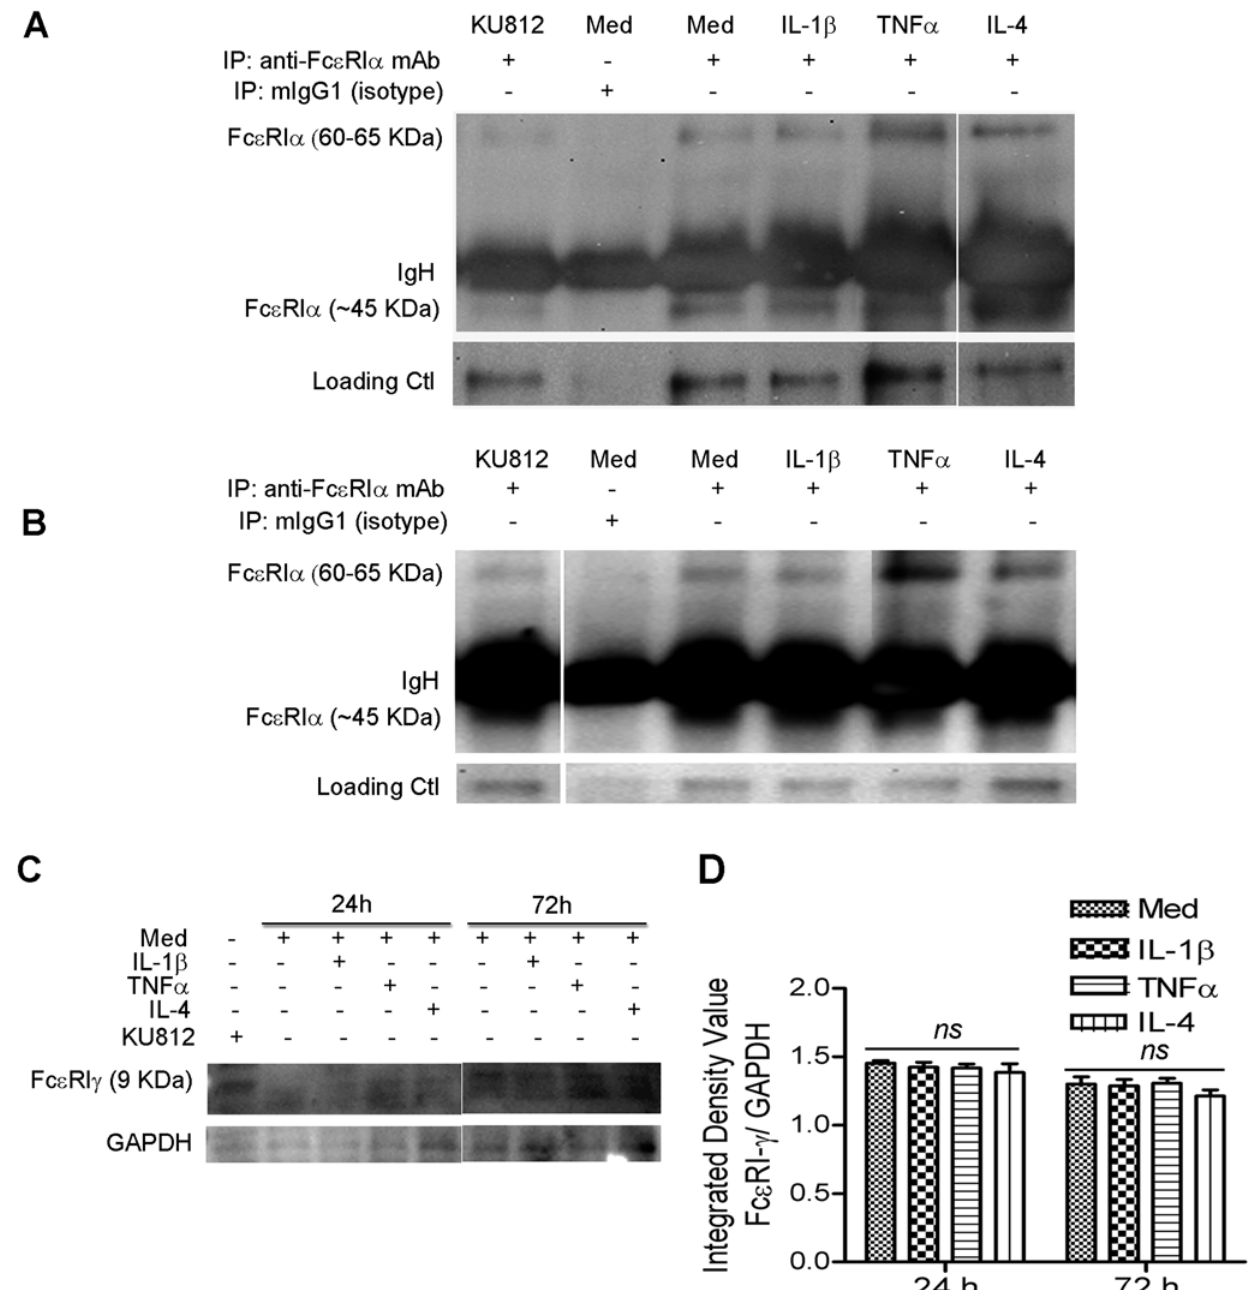
Figure 2. Fc e RI- a protein expression (24, 72 h) is upregulated by proinflammatory and Th-2 cytokines. Two-day serum-deprived primary B/TSM cells were cultured in presence or absence of IL-1 b , TNF- a or IL-4. Fc e RI- a protein from (A) 24 h and (B) 72 h culture cell lysates was Immunoprecipitated (IP) followed by Western blotting, as described in Materials and Methods section. Fc e RI- a protein was immunoprecipitated with either anti-Fc e RI a mAb 15/1 or with isotype antibody mouse IgG1 (MOPC21) for negative control. Non-specific bands from the same gels were used as loading control. (C) Fc e RI- c protein was analyzed by Western blotting and (D) presented as the ratio of 9 KDa Fc e RI- c -specific protein bands intensity over GAPDH (as internal control). Human basophilic KU812 cells were used as a positive control. Figures represent three separate experiments. ns , non-significant (p . 0.05). doi:10.1371/journal.pone.0006153.g002 Syk expression, B/TSM cells were transduced with a pseudotyped shRNA clone resulted in a highly significant and reproducible lentiviral vector expressing specific Syk-shRNA. Mock and decrease in Syk expression, as shown by Western blotting scramble sequence were used as negative controls. As shown in (Figure 5B). However, transduction with the control scramble shRNA failed to reduce Syk expression in B/TSM cells (Figure 5B). Figure 5A, more than 95% of the lentivirus-transduced cells were tGFP positive by FACS analysis. Transduction of cells with Syk-